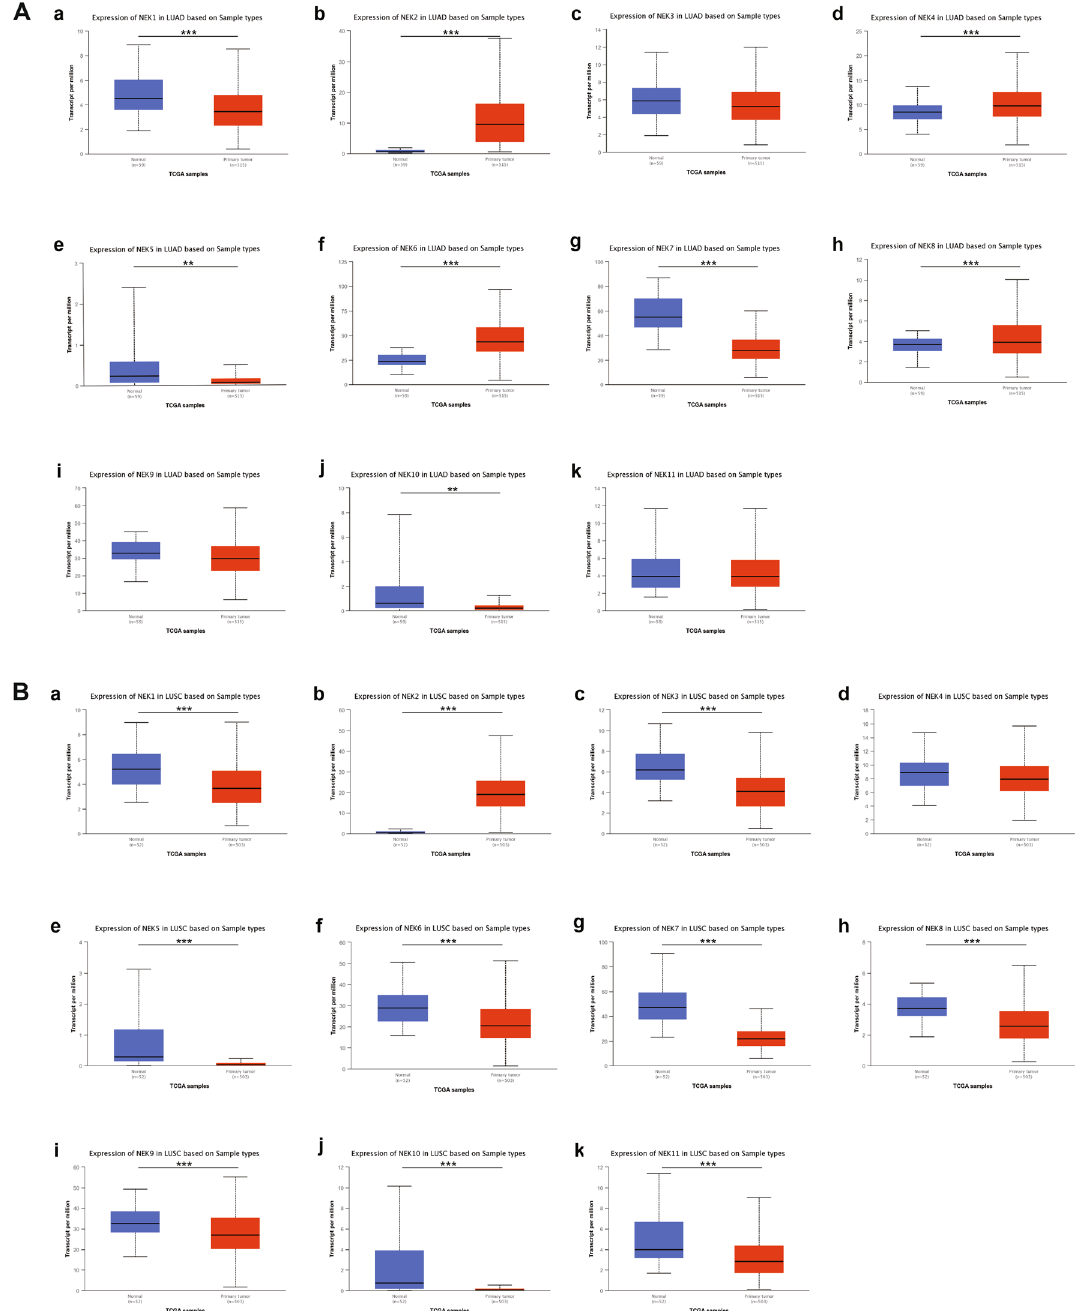
Figure 2. mRNA expression of distinct NEKs family members in NSCLC tissues and and normal lung tissues. * P < 0.05, ** P < 0.01, *** P < 0.001. A From a to k represent the mRNA expression of NEK1 to NEK11 in LUAD tissues and normal lung tissues; B From a to k represent the mRNA expression of NEK1 to NEK11 in LUSC tissues and normal lung